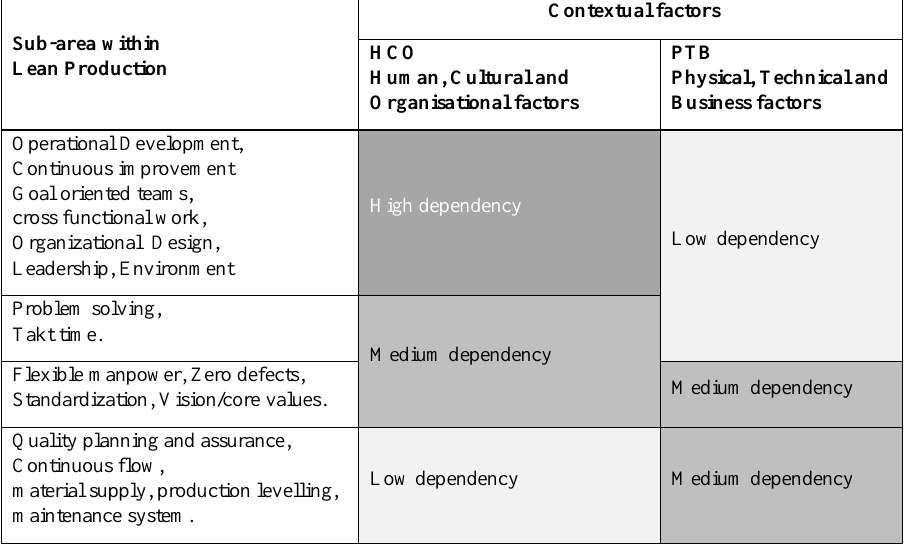
Contextual factors HCO PTB Human, Cultural and Physical, Technical and Organisational factors Business